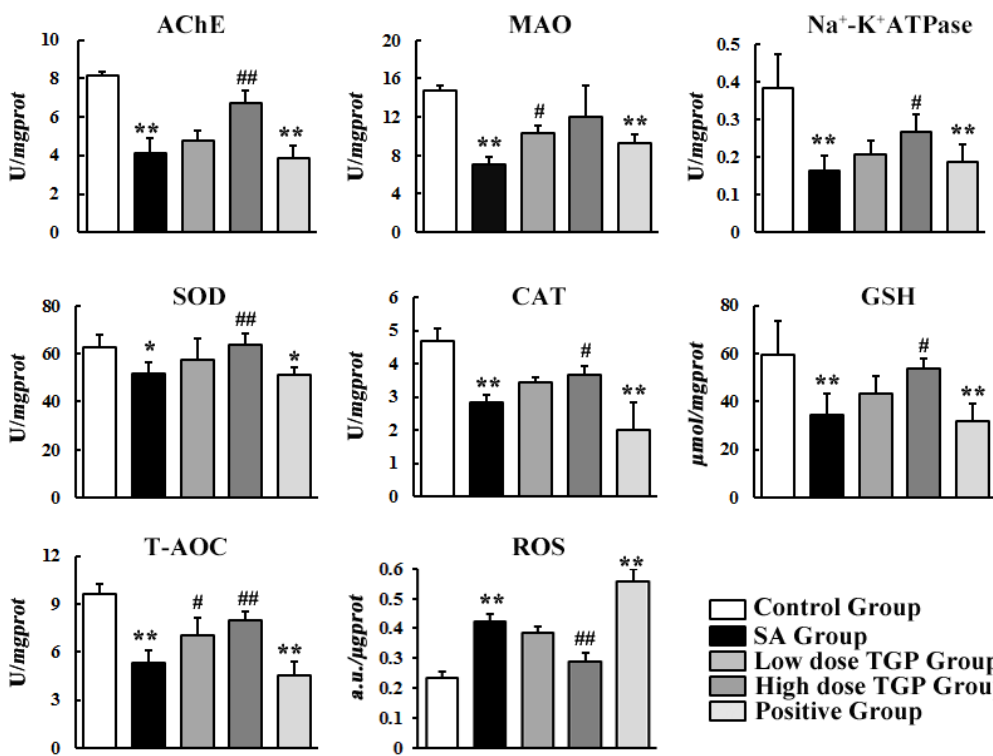
Figure 2. Determination results of rat brain samples collected from different groups. Each value was represented as mean ± SD (standard deviation). (* p < 0.05, ** p < 0.01 SA group vs. control group; # p < 0.05, ## p < 0.01 TGP group vs. SA group). AChE, acetylcholinesterase; MAO, monoamine oxidase;